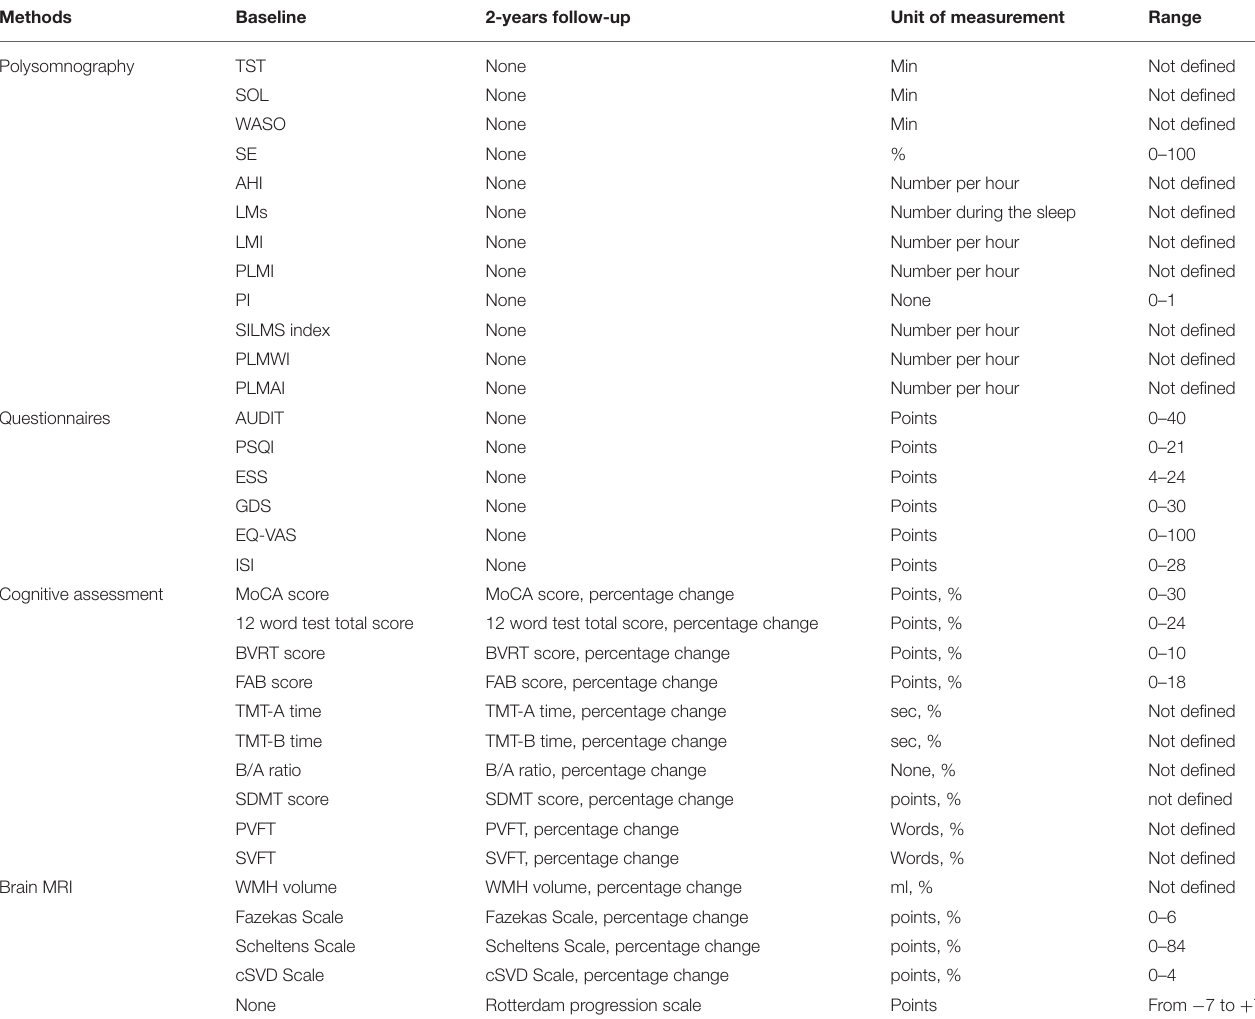
TABLE 1 | Examination